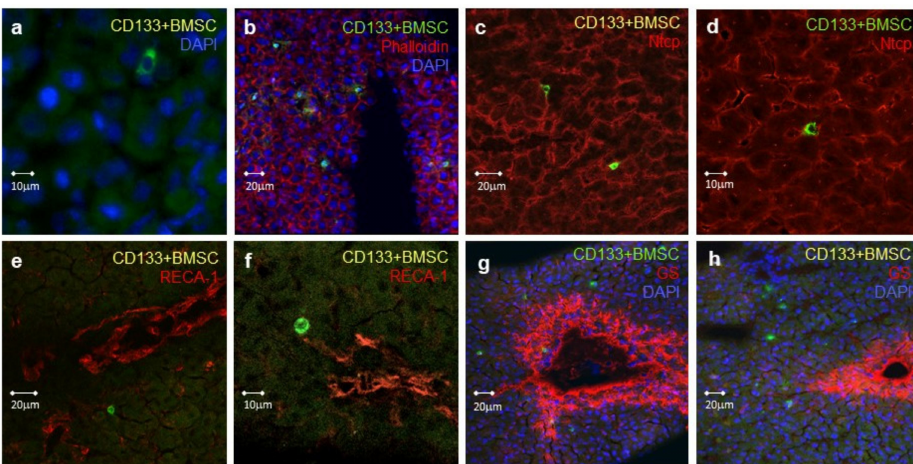
Figure 5. Characterization of hepatic homing of CD133 + BMSC in IPRL by confocal fluorescence microscopy. Rat livers were perfused with CD133 + BMSC, which were stained by anti-CD45 antibodies (green). ( a ) Cell nuclei were stained by DAPI (blue). ( b ) Demonstration of CD133 + BMSC (green) co-localization with hepatocytes visualized by actin-staining of hepatocytes with TRITC-labelled phalloidin (red). Nuclear staining with DAPI (blue). ( c , d ) CD133 + BMSC (green) co-localization to hepatocytes, specifically detected by Sodium taurochlate cotransporting protein- (Ntcp-) staining (red). Ntcp is exclusively expressed in hepatocytes. ( e , f ) Confirmation of CD133 + BMSC (green) extravasation with distance to LSEC. Latter is specifically detected by the endothelial cell marker RECA-1 (red). ( g , h ) CD133 + BMSC (green) are predominantly localized to hepatic zone 1 and 2 but rarely co-located to the inner zone 3 indicated by staining of glutamine synthetase (GS; red). The latter is mainly expressed in hepatocytes of zone 3 close to the central venule of the acinus. Nuclear staining with DAPI